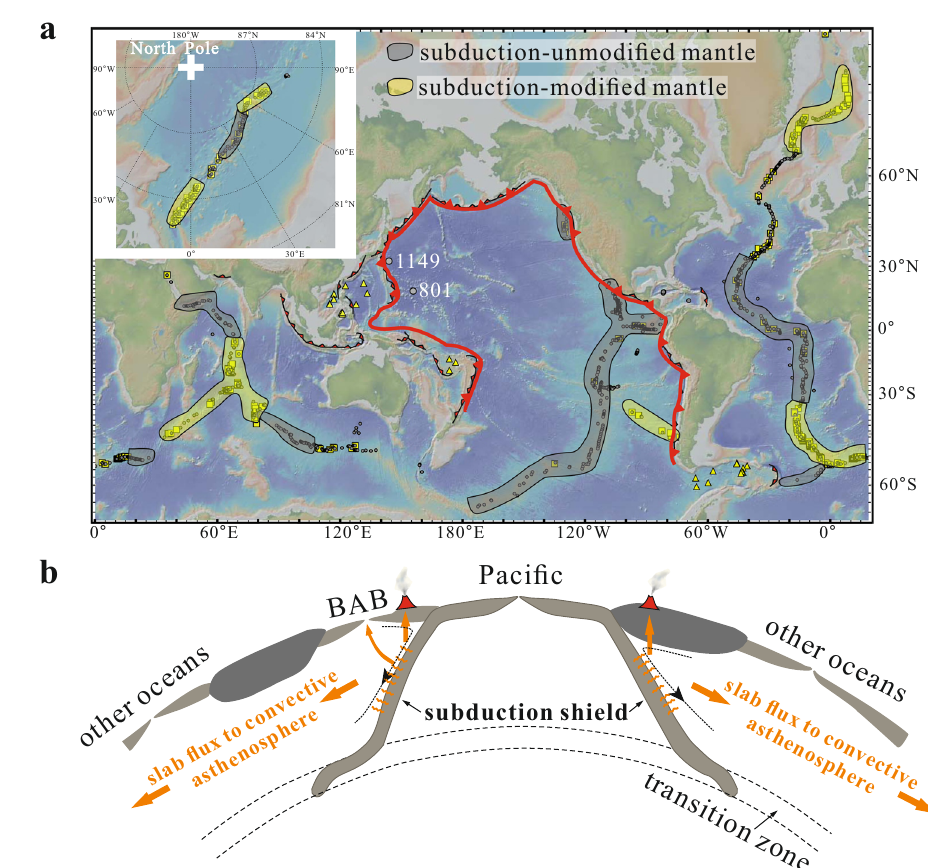
Fig. 7 The subduction in fl uence on ocean ridge basalts outside the Paci fi c subduction shield. a Distribution of global mid-ocean ridge basalts with back- arc signatures (yellow squares) and b schematic model of the subduction shield. a Mid-ocean ridge basalts (MORB) samples which do not pass the back- arc basin basalt (BABB) fi lter (gray dots) are also plotted. The majority of the global BABB-like MORB (yellow symbols) are distributed outside the Paci fi c subduction zones shown by the red lines. Yellow-shaded blobs denote ridge sections where >20% of MORB pass the BABB fi lter, indicating the presence of subduction-modi fi ed mantle beneath the ridges. Gray-shaded sections denote sections where <3% of MORB pass the BABB fi lter, suggesting the dominance of subduction-unmodi fi ed mantle beneath the ridges. The circum-Paci fi c subduction zones are shown by the thick red curves. b The circum- Paci fi c subduction zones form a subduction shield to prevent subduction contribution to Paci fi c MOR magmatism. Slab fl ux (water-rich component off the slab, represented by orange curves) would metasomatize the overlying mantle wedge right above the subducted slab. The metasomatized mantle would partially be dragged downwards by corner fl ow at mantle wedge and would not contribute to the arc volcanism. They would eventually mix into the convecting mantle to feed BAB and MOR magmatism. Old Paci fi c MORB glasses from drilled holes 1149 and 801 40 (light gray dots) all have none ratios passing the BABB fi lter, and basalts from the Fiji 66 , Sulu Sea 67 , South China Sea 68 , Philippine Sea Plate 31,69 , and Drake Passage 70,71 (yellow triangles) outside the Paci fi c subduction zones have BABB signatures, consistent with the subduction shield model. Global MORB data source can be found in the Supplementary Data 4. Bathymetry from GeoMapApp 72